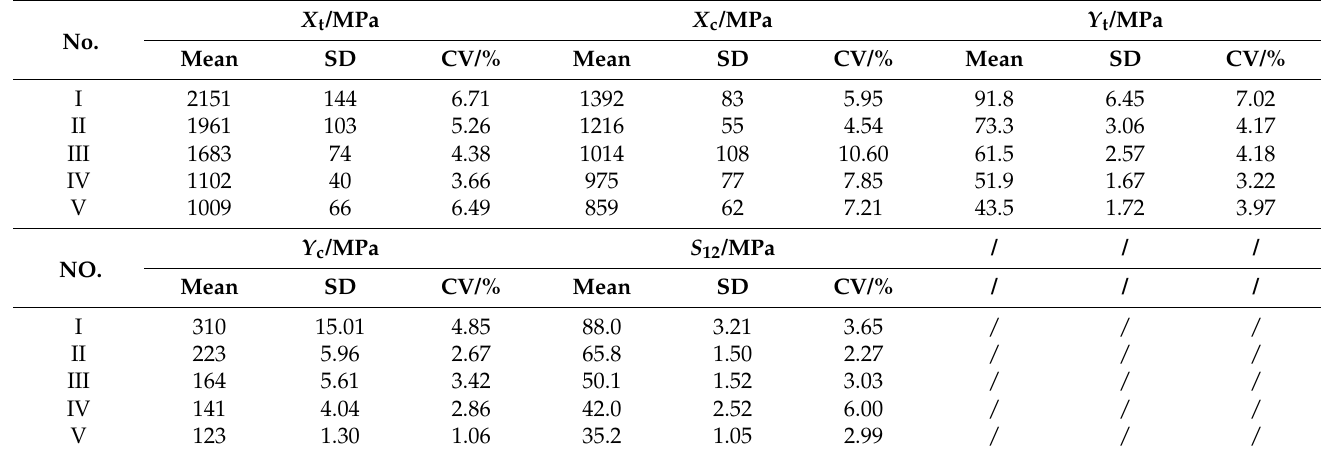
Table 5. Statistical values of strength properties of five batches of